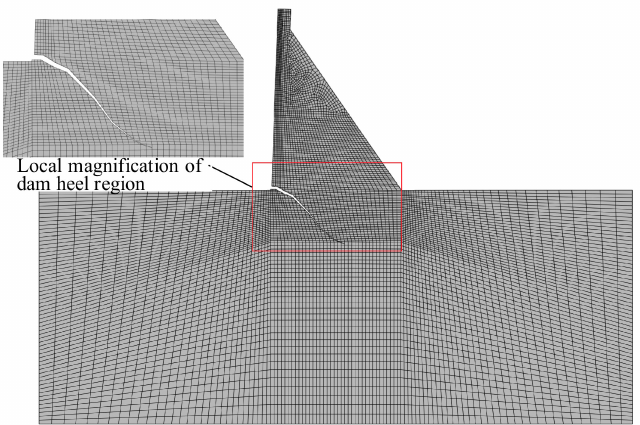
Figure 18. Crack propagation pattern of the dam heel (magnified by 1000 times).